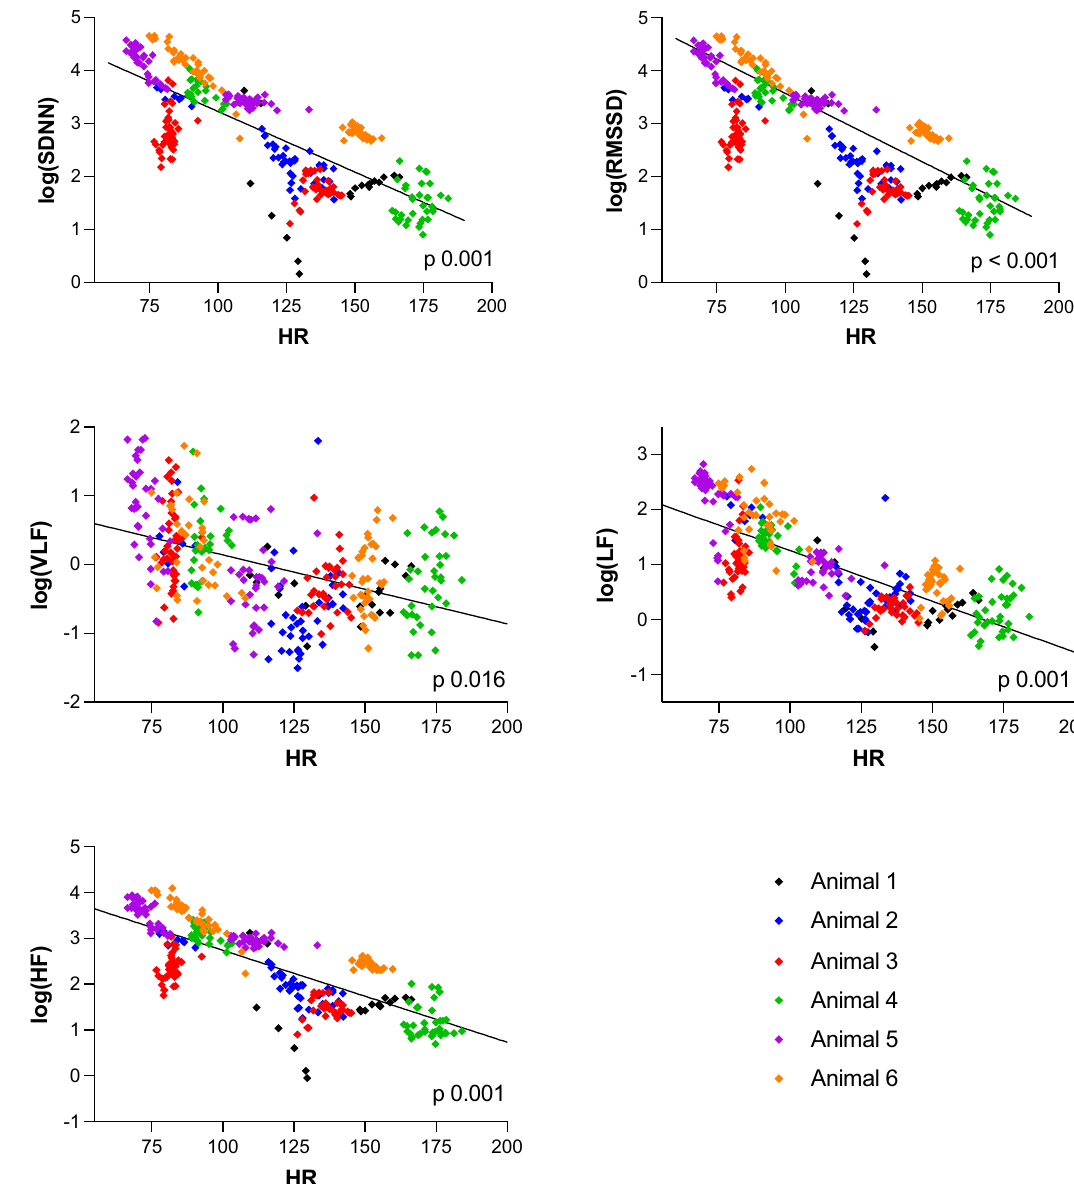
Figure 3. Clustered linear regression of heart rate and HRV measures in six healthy, anaesthetised, newborn piglets exposed to 3 h of normothermia (38.5–39.5 °C) and 3 h of hypothermia (33.5–34.0 °C). SDNN: Standard deviation of normal-to-normal interval; RMSSD: Root mean square of successive differences; log(VLF): log- transformed power in the very low frequencies; log(LF): log-transformed power in the low frequencies; log(HF): log-transformed power in the high frequencies; HR: heart